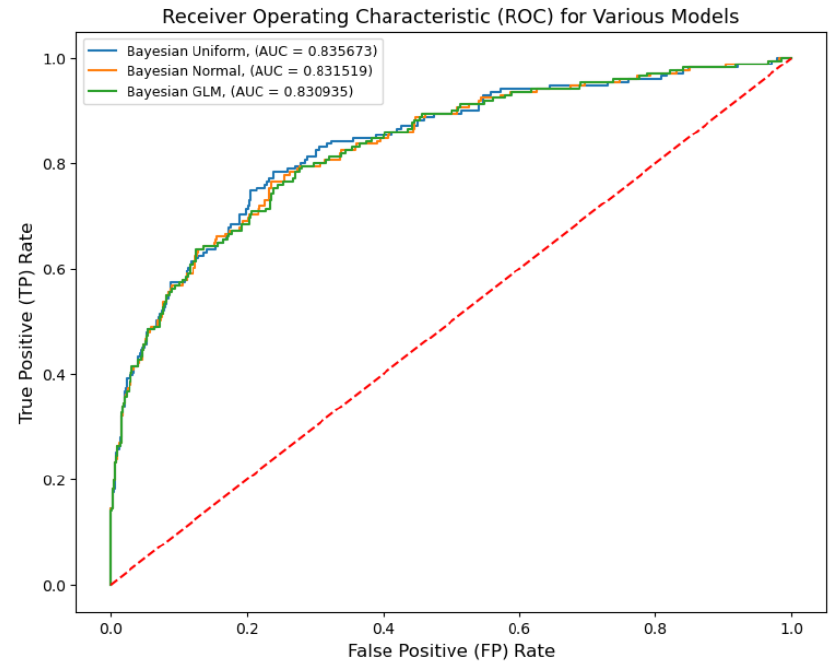
Figure 17. ROC-AUC graph for Bayesian models using uniform, normal, and built-in GLM priors.